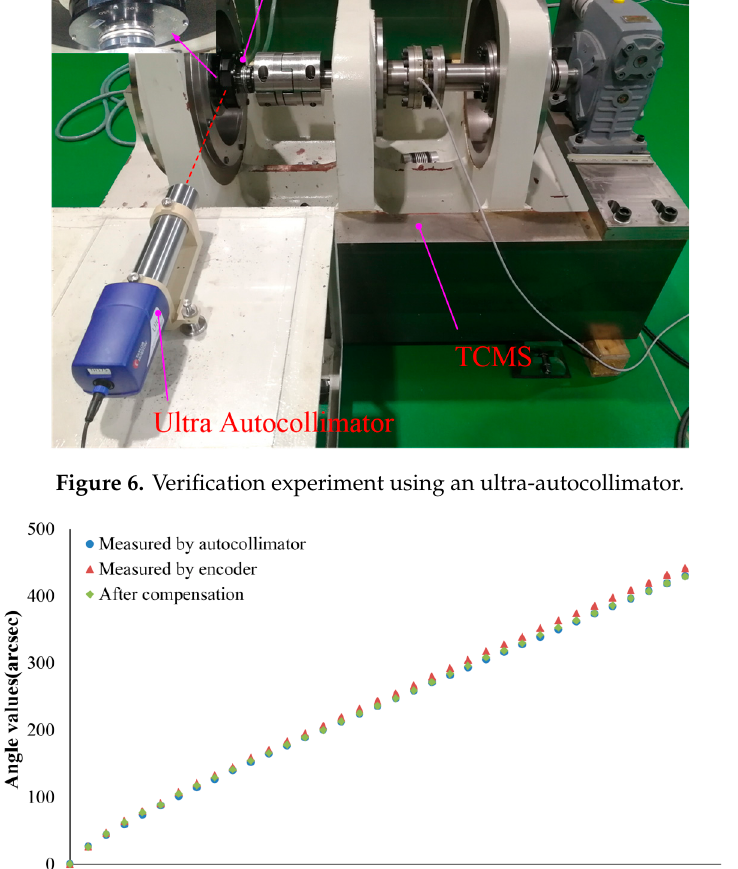
Figure 7. The chart of data comparison.